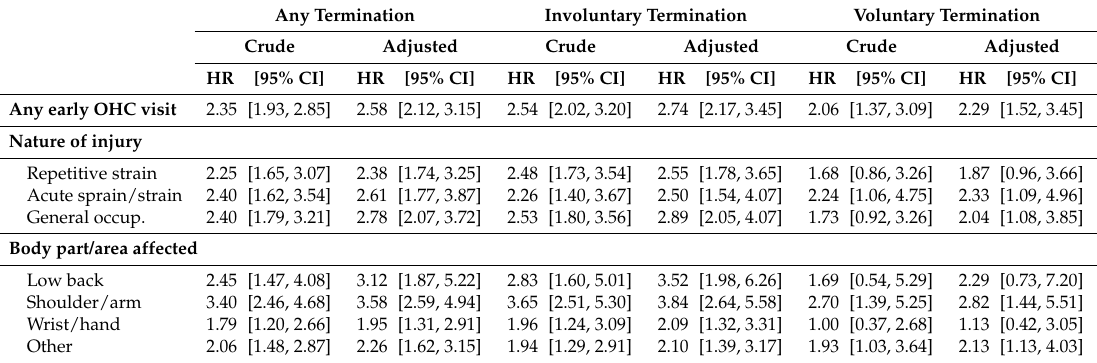
Table 3. Crude and adjusted 1 associations between occupational health center (OHC) visits and employment termination within the 60-day probationary period.